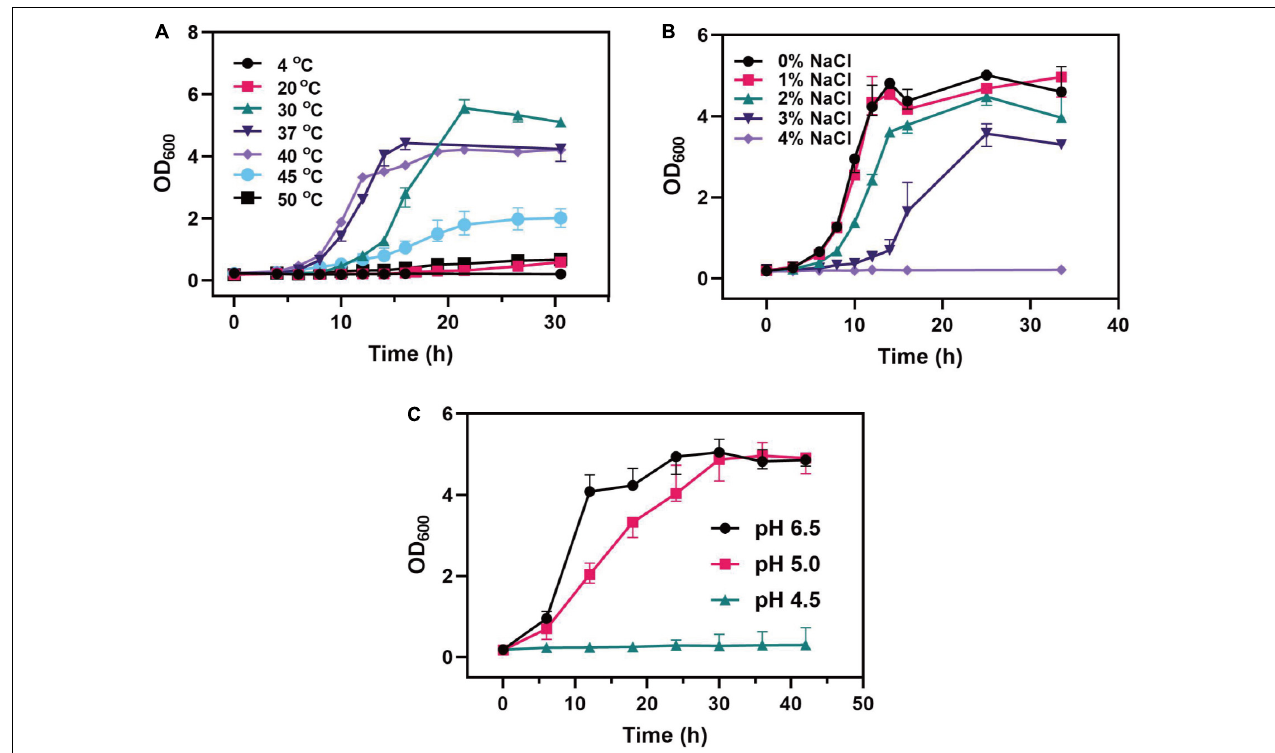
FIGURE 3 | Effects of (A) different temperatures, (B) NaCl concentrations, and (C) pH values on the growth of the C. tyrobutyricum L319 strain.